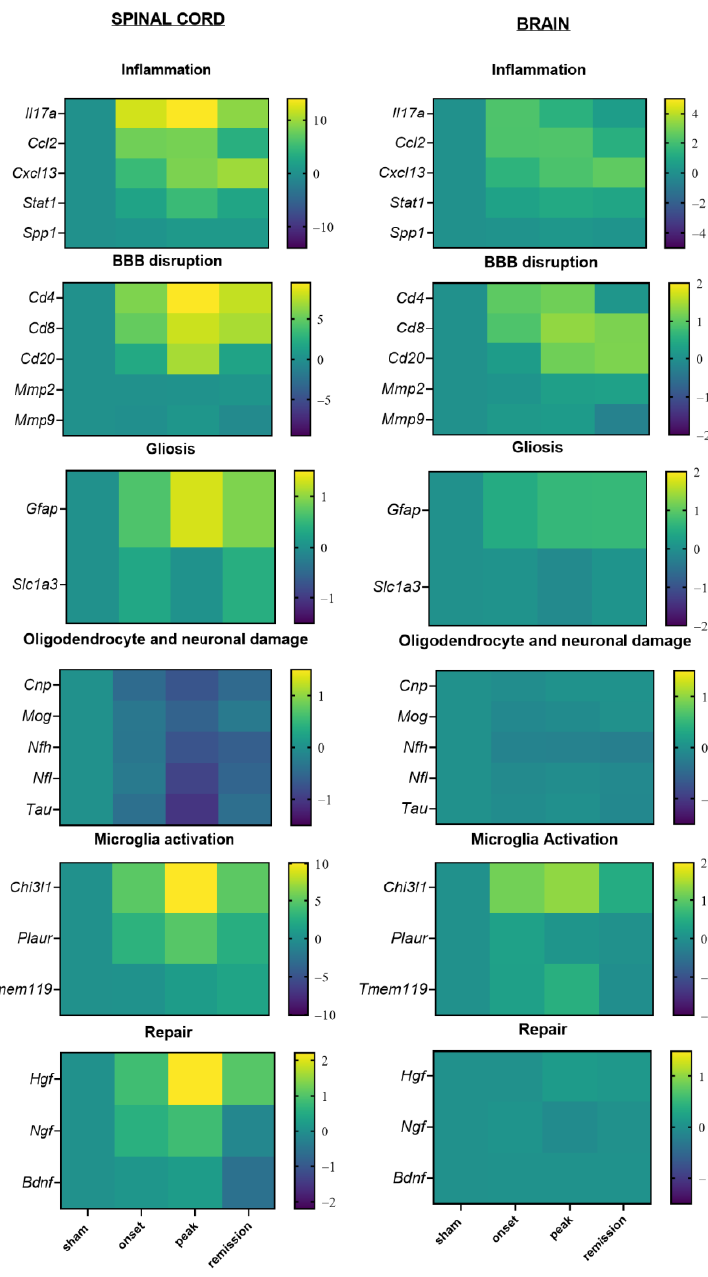
Figure 8. Heatmap representing the differential expression of genes in the spinal cord ( left ) and brain ( right ) during the different phases of PLP-induced EAE. The levels of mRNA transcripts for the selected genes were measured in spinal cord and brain samples isolated from EAE mice at the onset, peak, and remission phase and were compared to adjuvant controls (sham). A number of 3 to 5 mice was used in the experiment (logarithmic scale bars).